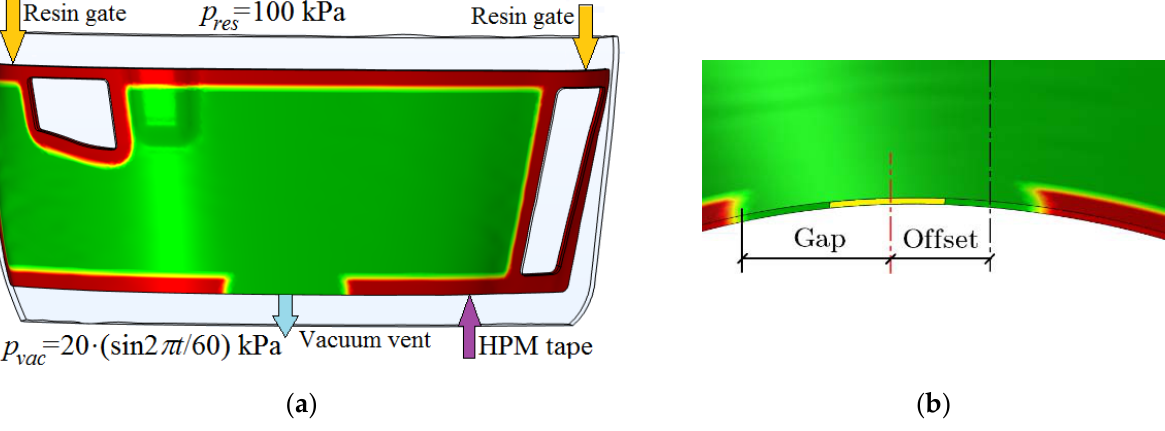
Figure 2. Layout of the vacuum infusion of the composite part: ( a ) HPM, resin injection gates and vacuum vent location on the preform; ( b ) The location of the vacuum vent relative to the axis divides the part into two approximately equal parts, and the distance from the vent to the edges of the HPM tape.